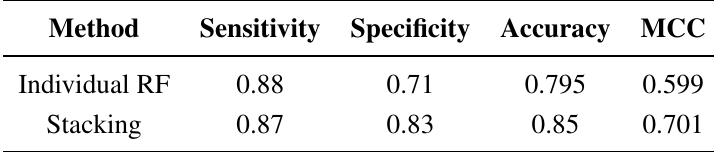
Table 4. Performance of stacking-based ensemble learning method and the individual RF